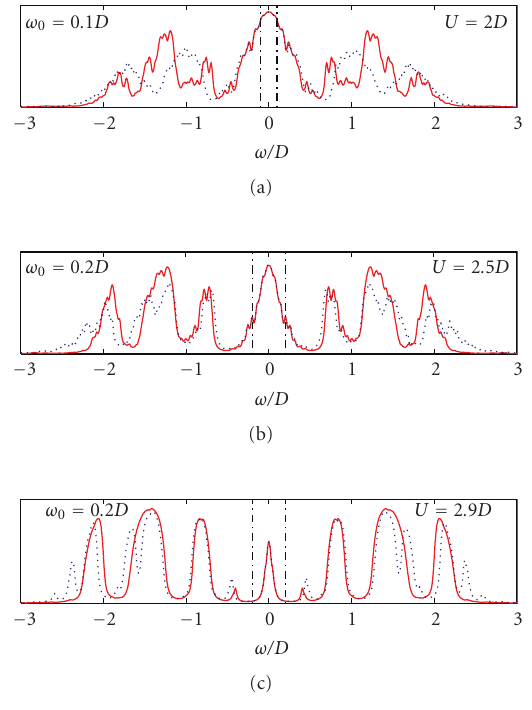
Figure 6: Comparison between the DMFT momentum-integrated spectral function ρ ( ω ) = − 1 /π Im G ( ω ) ( G ( ω ) being the local Green’s function) for the Hubbard-Holstein model (dotted line) and the e ff ective purely electronic Hubbard model with U = U e ff (solid line). The low-energy part of the spectra is perfectly reproduced by the e ff ective model, while the high-energy features present phononic signatures that cannot be plugged in an e ff ective static interaction (after Sangiovanni et al. [45]).